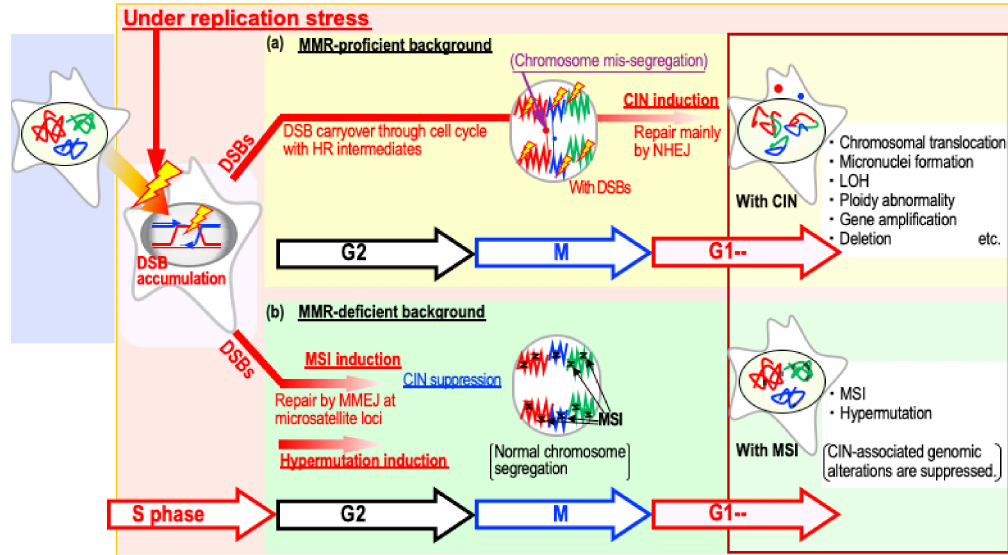
Figure 2. Model of distinct chromosomal instability (CIN) and microsatellite instability (MSI) induction processes triggered by replication stress. Induction of both CIN and MSI is triggered by replication stress. Although CIN arises when replication-stress-associated double strand breaks (DSBs) are not e ff ectively repaired by homologous recombination (HR), MSI arises when those DSBs are erroneously repaired by microhomology-mediated end joining (MMEJ) in an mismatch repair (MMR)-deficient background. MSI induction is associated with the induction of hypermutation—a context in which CIN induction is generally suppressed. NHEJ: non-homologous end